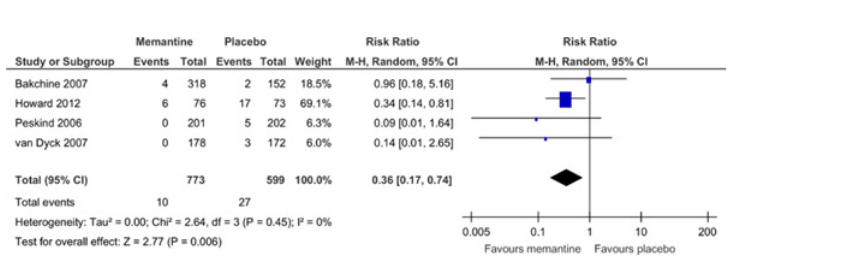
Fig 10. Forest plot of discontinuation due to inefficacy (4 studies, n = 1372). * Negative SMD values favor memantine; positive SMD values favor placebo. † RR < 1 favors memantine; RR > 1 favors placebo.